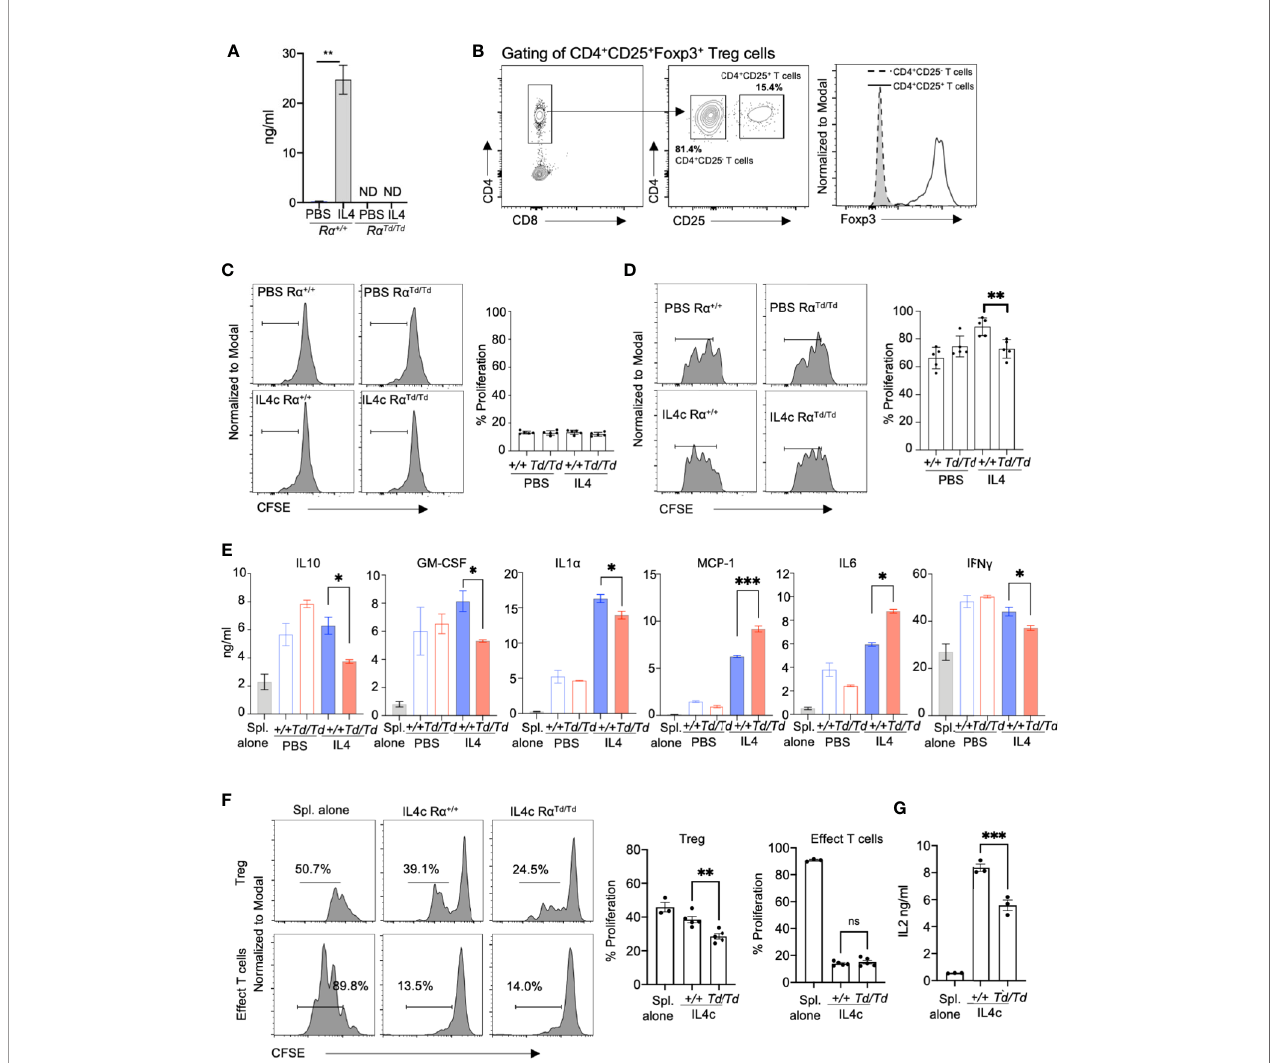
FIGURE 5 | Macrophage-derived RELM a promotes regulatory T cell responses. Peritoneal macrophages from R a +/+ or R a Td/Td mice were treated with PBS or IL-4 (20ng/mL) for 24h, washed then adherent macrophages were co-cultured for three days with CFSE-labeled splenocytes with anti-CD3 at a 1:10 (Mac : Splen ratio). (A) RELM a secretion by peritoneal macrophages treated in vitro with PBS or activated with IL-4. (B) T cell gating strategy. (C, D) Proliferation of CD4 + CD25 - T cells (C) and CD4 + CD25 + FoxP3 + Tregs (D) when splenocytes are co-cultured with peritoneal macrophages treated in vitro with PBS or IL4 (E) Cytokine secretion measured at day 3 post-culture. (F) Proliferation of CD4 + CD25 - T cells and CD4 + CD25 + FoxP3 + Tregs when splenocytes are co-cultured with F4/80+ peritoneal macrophages puri fi ed from in vivo IL-4c-treated mice. (G) IL-2 secretion measured at day 3 post-culture. ND, not detected; NS, not signi fi cant. *, p ≤ 0.05; **, p ≤ 0.01; ***, p ≤